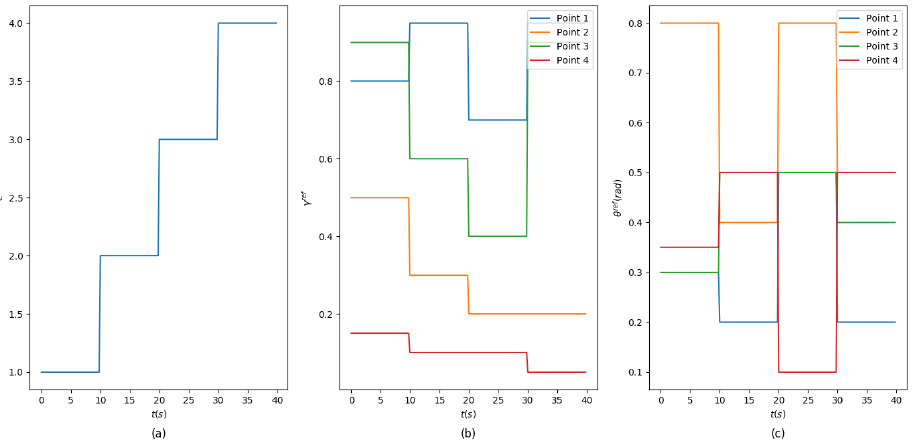
Figure 9. Trajectory of flight conditions. ( a ) Condition indexes. ( b ) Trajectories of optimal radius factor for each control point. ( c ) Trajectories of optimal angle for each control